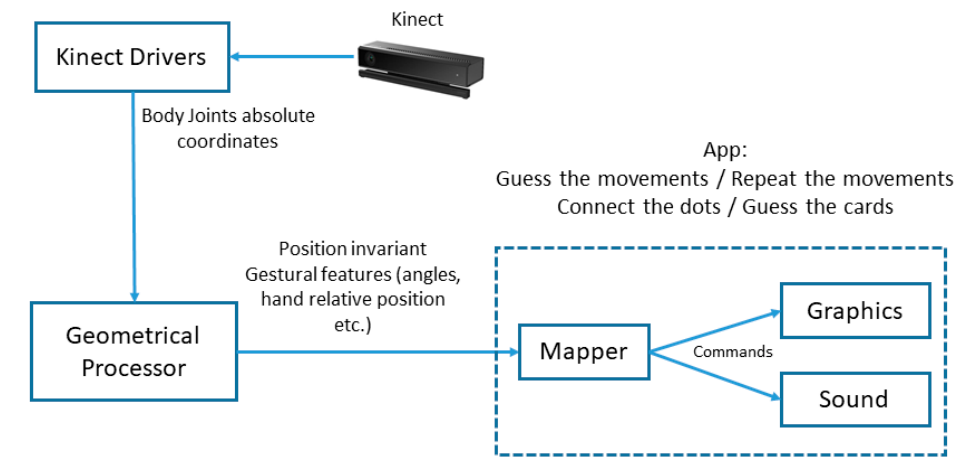
Figure 2. SEMI Software Architecture.